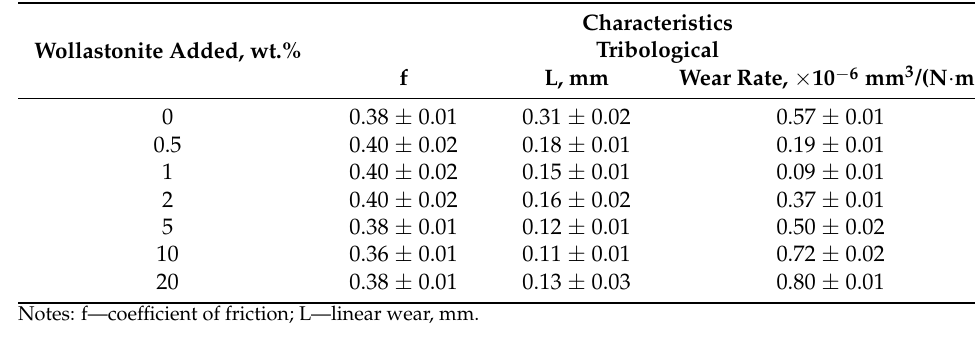
Table 3. Coefficient of friction, linear wear, and wear rate of the UHMWPE and PCM. Wollastonite Added, wt.%